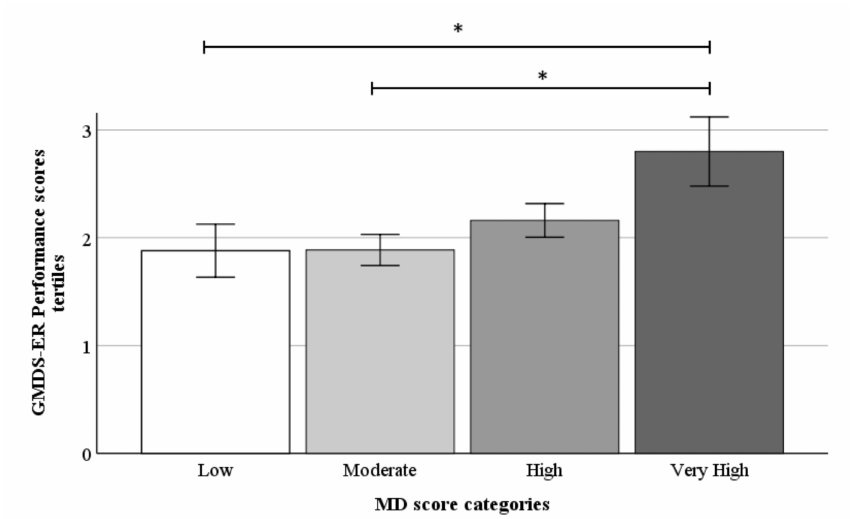
Figure 1. The children’s performance in tertiles (low = 1<; medium = >1 to 2<; high = >2) stratified by the Mediterranean diet score categories ( n = 44). Data are shown as mean ± SEM. * p <